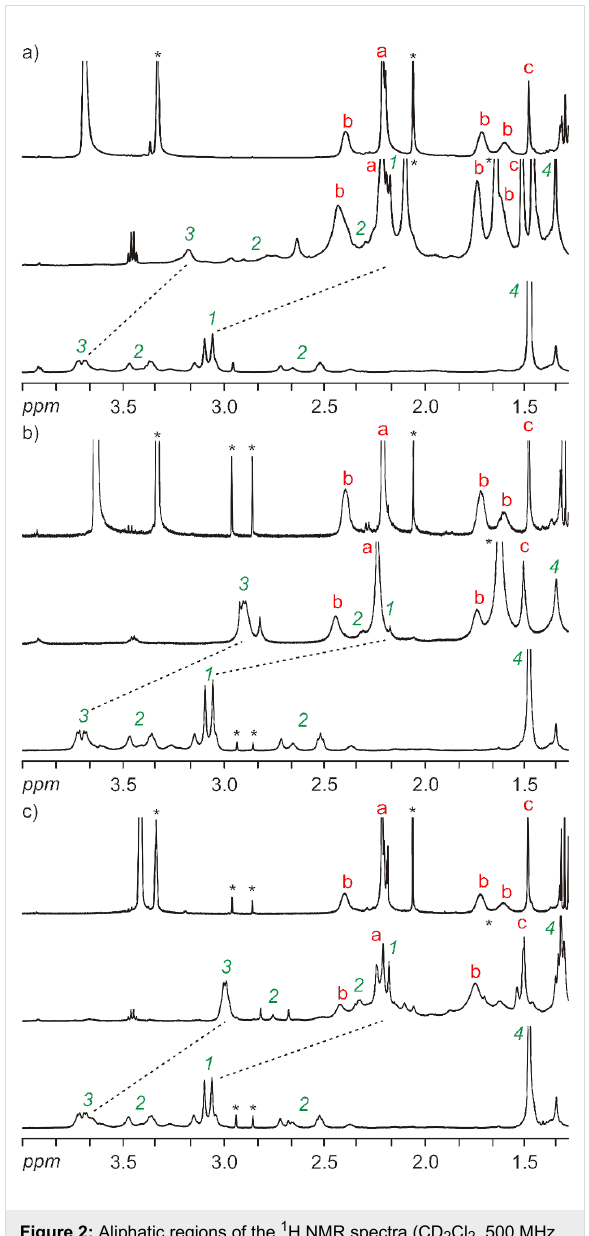
Figure 2: Aliphatic regions of the 1 H NMR spectra (CD 2 Cl 2 , 500 MHz, 298 K, 2.3 mM) of (a) 10 (top), 17@10 (center) and 17 (bottom), (b) 12 (top), 18@12 (center) and 18 (bottom), and (c) 14 (top), 19@14 (center) and 19 (bottom). Because of the low solubility of the wheel components 10 , 12 and 14 , the samples were dissolved in CD 2 Cl 2 / CD 3 OD (10:1). Red letters assign signals of the wheels as shown in Scheme 2, green numbers those of the axles as shown in Scheme